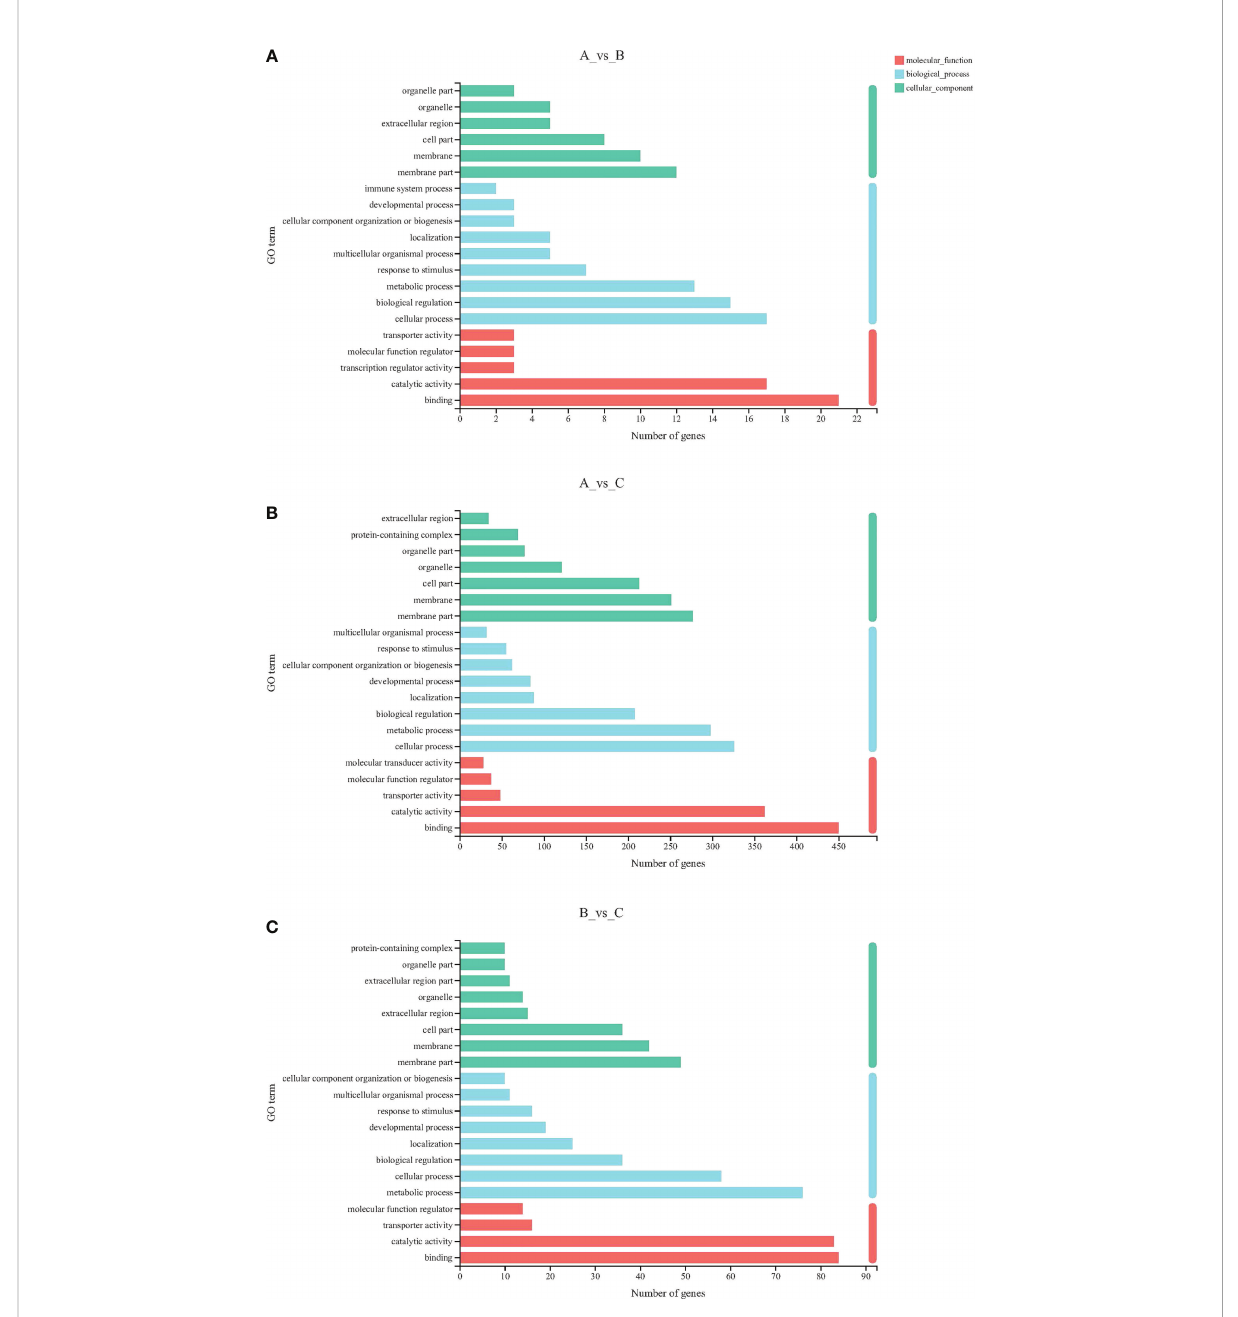
FIGURE 2 GO classi fi cation statistical histogram. (A) 13°C group compared with 18°C group; (B) 8°C group compared with 18°C group; (C) 8°C group compared with 13°C group. The Y-axis represents the secondary classi fi cation term for GO. The X-axis represents the number of genes. Three colors represent three